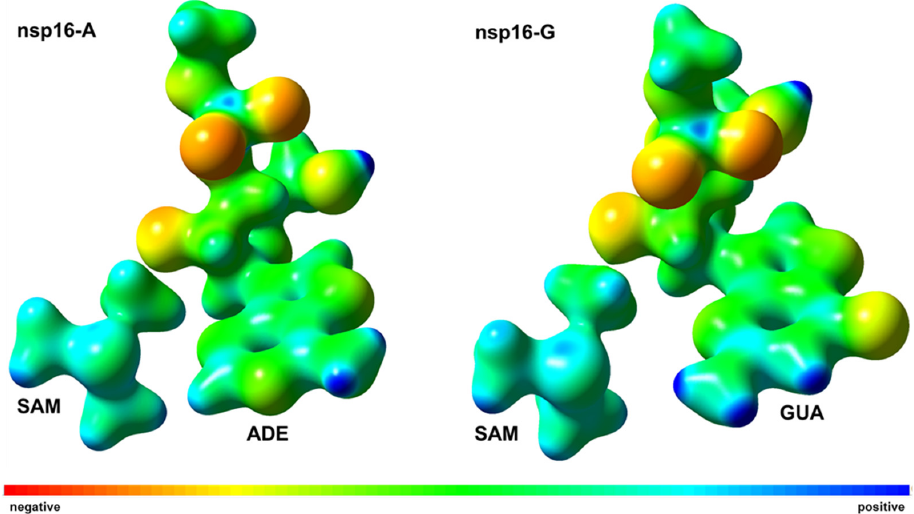
Figure 7. Map of electrostatic potential of the nsp16-A ( left ) and nsp16-G ( right ) systems on the reacting systems at the TS computed at DFT/MM level.